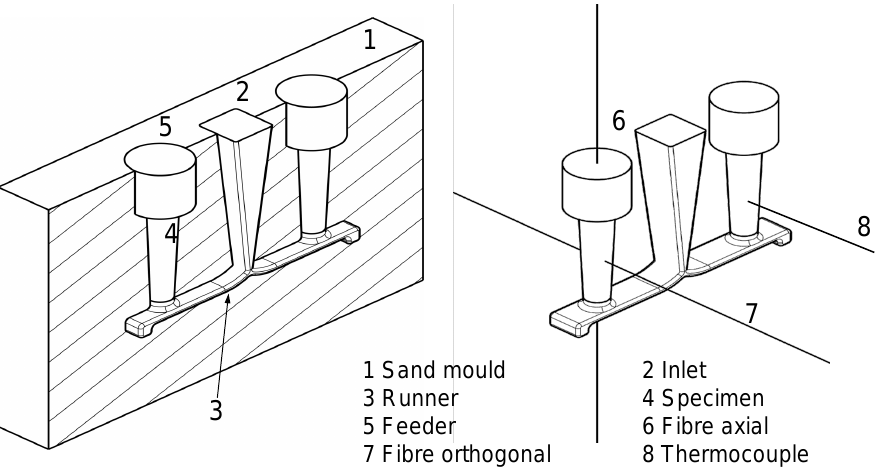
Figure 4. Components of the casting